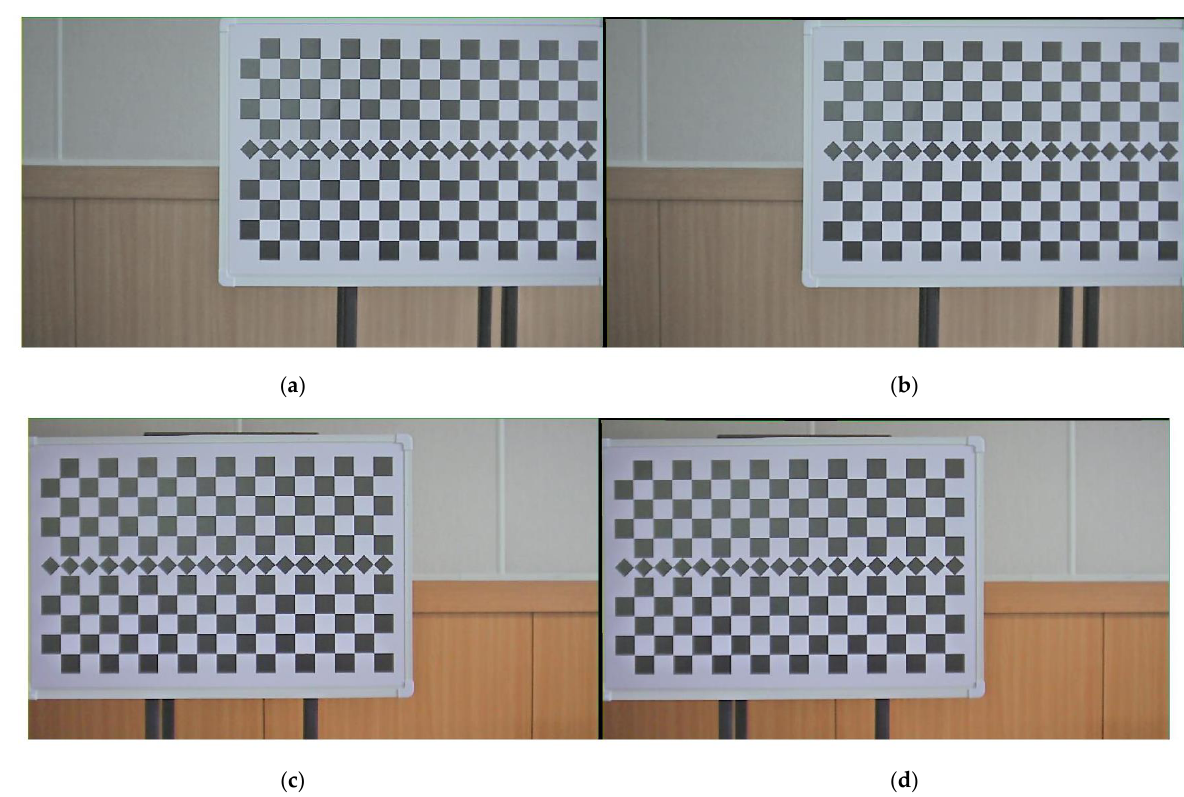
Figure 16. The results of the checkboard calibration of distortions: ( a ) Image corrected for distortion using Zhang’s algorithm, ( b ) image corrected using the proposed algorithm, ( c ) image corrected for distortion using Zhang’s algorithm, and ( d ) image corrected using the proposed algorithm.